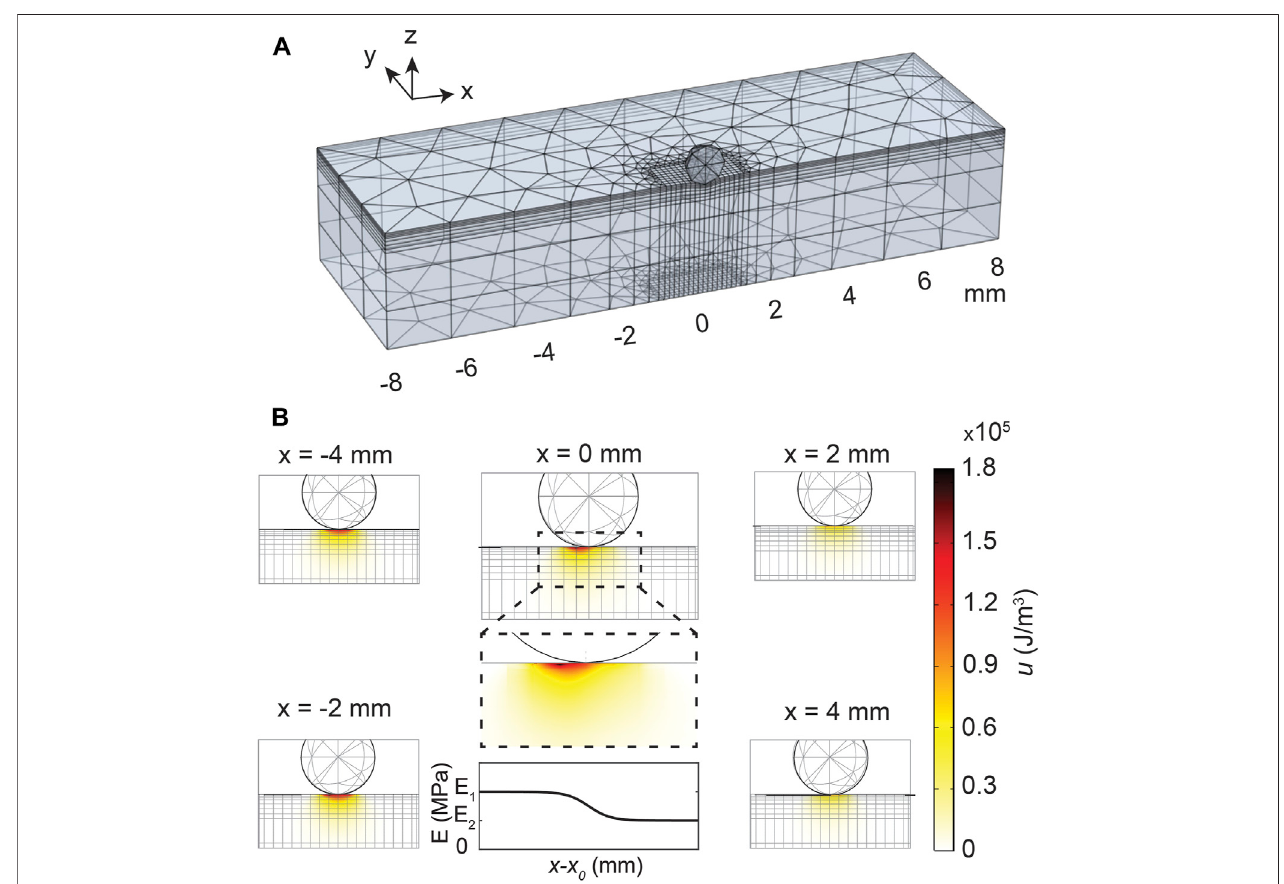
FIGURE 2 | (A) Meshing used in the fi nite element simulations for 1D modulus pro fi les, where the fi nely meshed region at the destination moves along with the indentation position. Symmetry in the y -axis isassumed toreducecomputation time. (B) Elasticstrain energy density, u , distribution for indentations at various positions acrosstheinterfaceforasigmoidalpro fi le (Eq.2b) withwidth w (cid:1) 10.0 mm,shownwiththebottomcenterplot.Theinsetofthe u pro fi leattheinterface, x (cid:1) 0 mm,shows the heterogeneous u pro fi le across the interface, leading to blurring of the recorded stress response in indentation measurements.